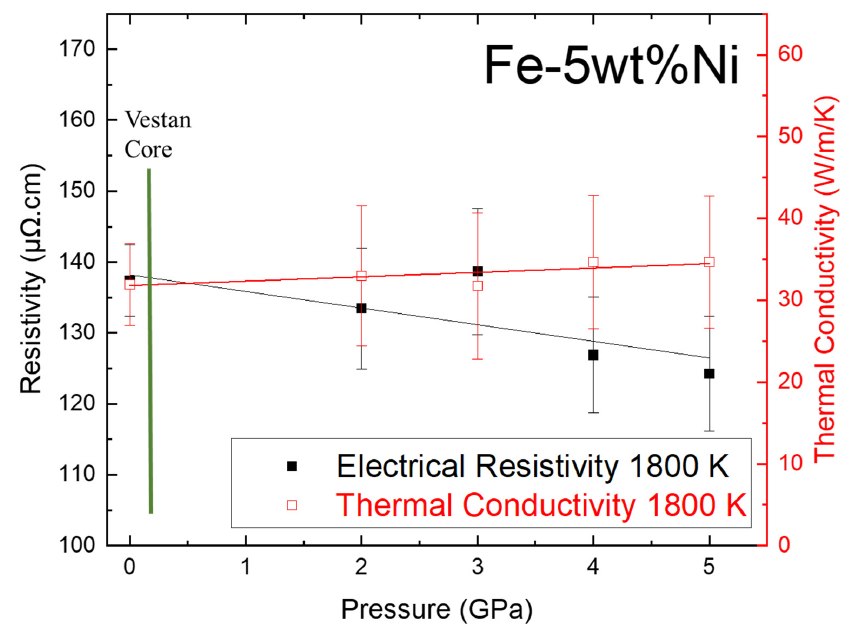
Figure 6. High pressure electrical resistivity and thermal conductivity data at 1800 K from this study plotted with 1 atm data [17] for purpose of interpolation to Vestan CMB pressure of 0.2